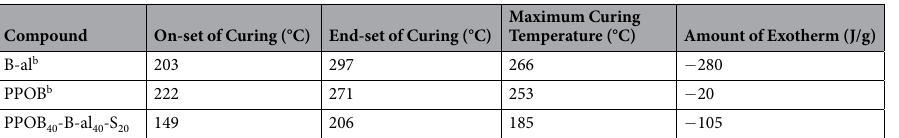
Maximum Curing Temperature (°C) Amount of Exotherm (J/g)